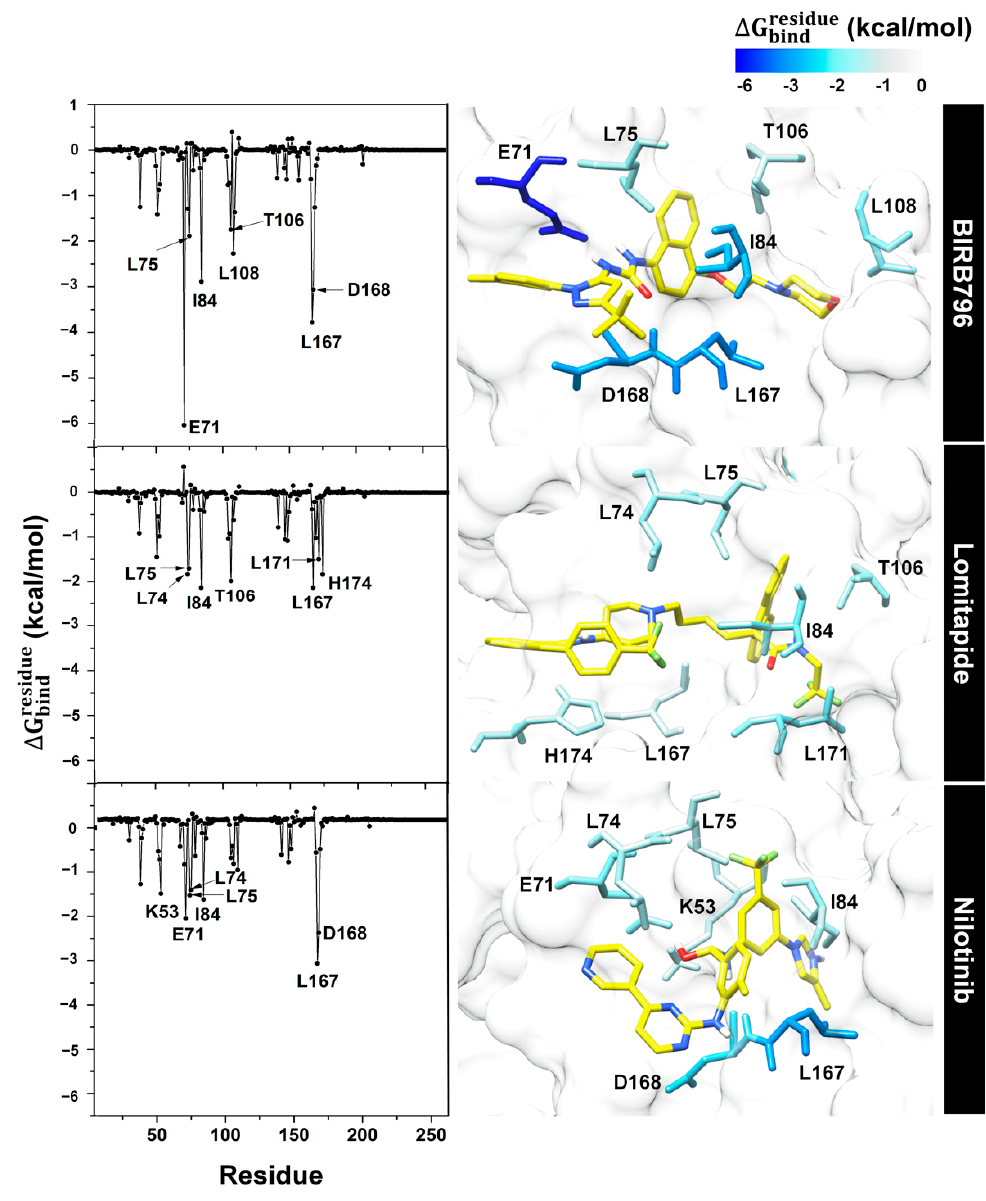
Figure 6. Per-residue free energy decomposition of amino acids involved in ligand binding where the highest to lowest ∆ G bind contribution (more negative value) was shaded from dark blue to white.